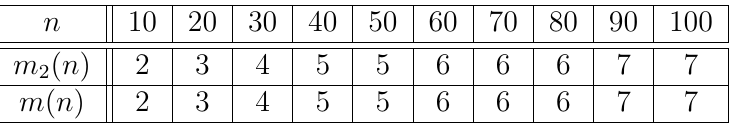
Table 10: Minimum largest term m nected) graphical partitions of n